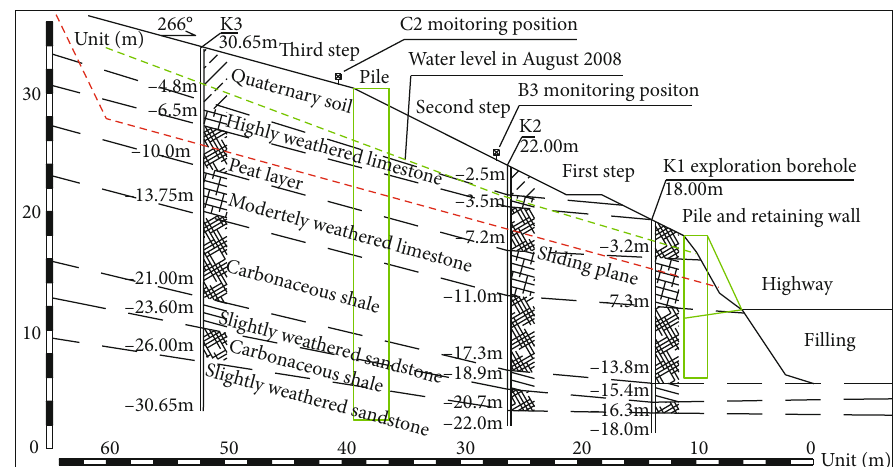
Figure 1: Engineering geologic pro fi le.